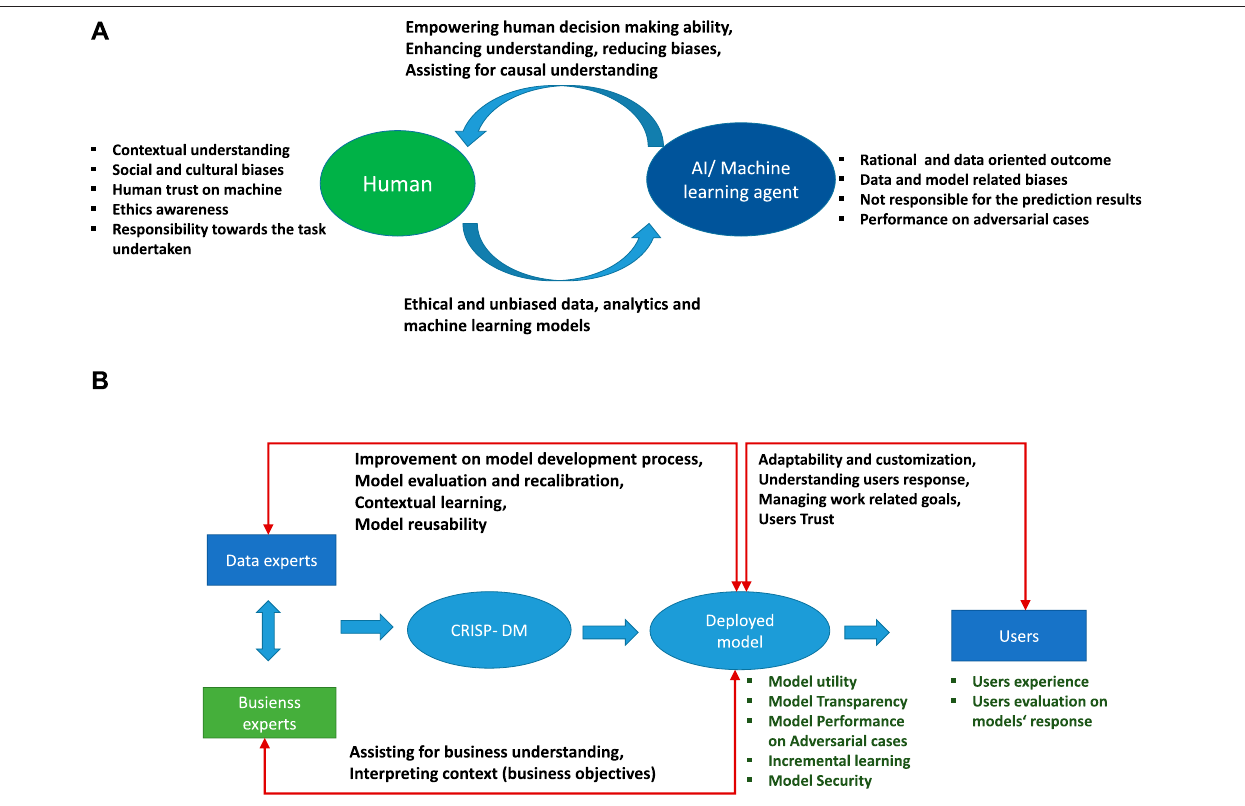
FIGURE4|(A) SchematicviewofinteractionsbetweenhumansandAIandMLagents. (B) Schematicviewofpost-deploymentofMLmodelnotleftinisolationbut continuously updating and addressing human concerns by allowing human interactions to ensure a human-centered data